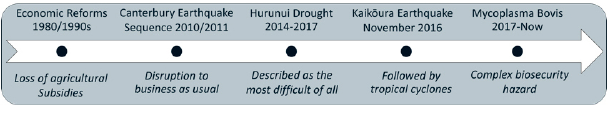
Fig. 3 . Time line of major events in the Hurunui